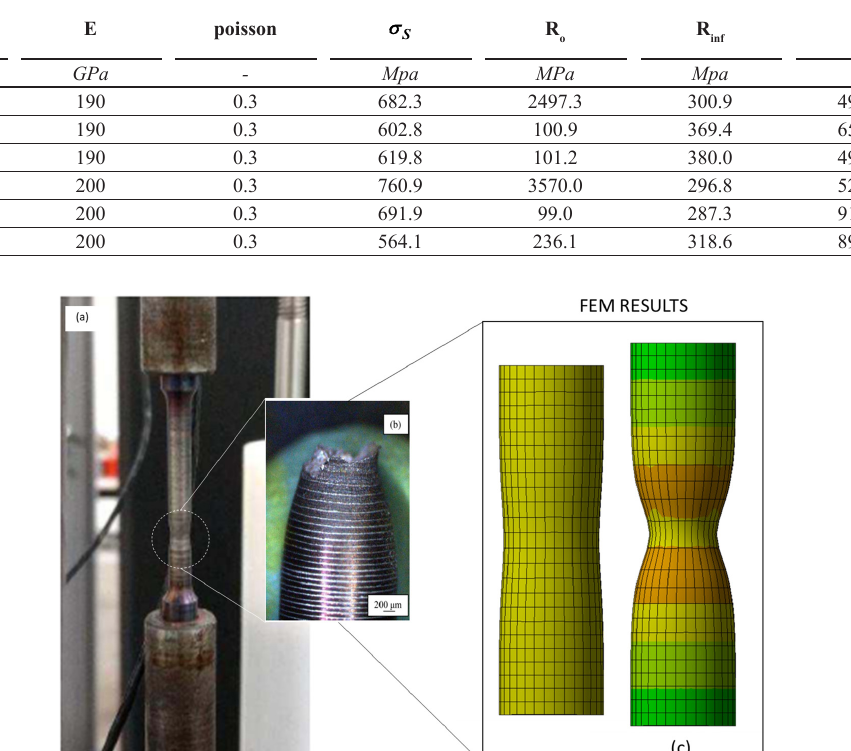
Table 7. Constants that determine the elastic isotropic and plastic isotropic region of each specimen for ST maraging steels used as input on ANSYS software.